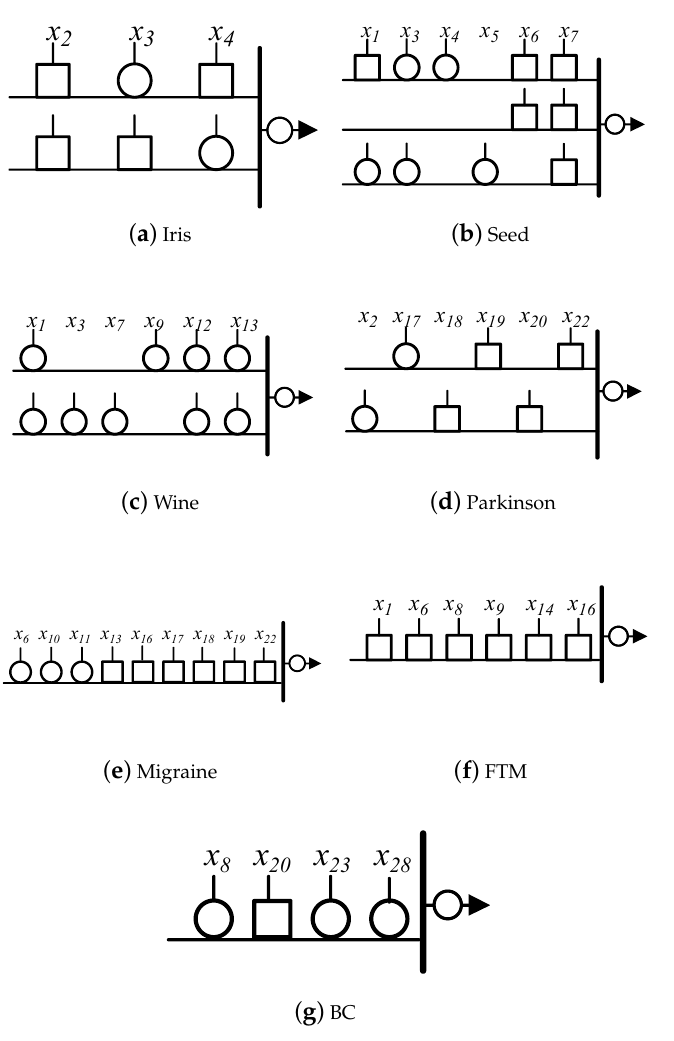
Figure 7. Typical structures of the pruned LDNM for each dataset. Table 7. Classification results of the trained LDNM and pruned LDNM for each